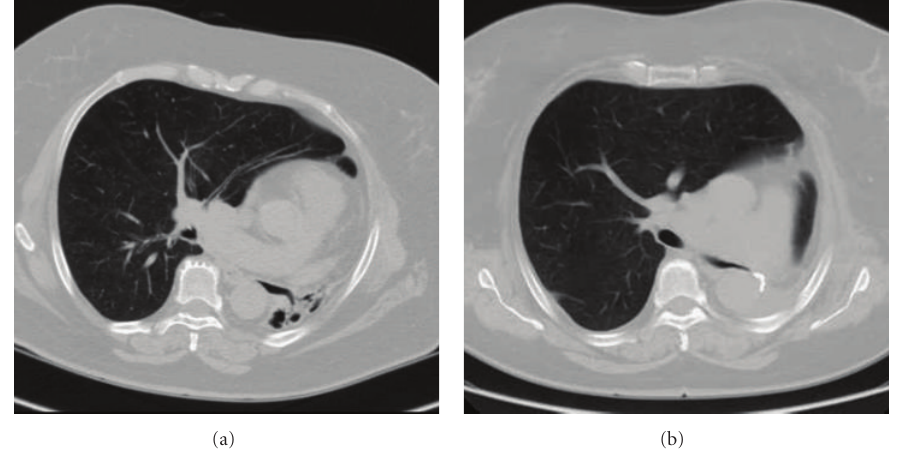
Figure 2: The axial scans in lung window imaging reconstruction before (a) and after (b) the left pneumonectomy.